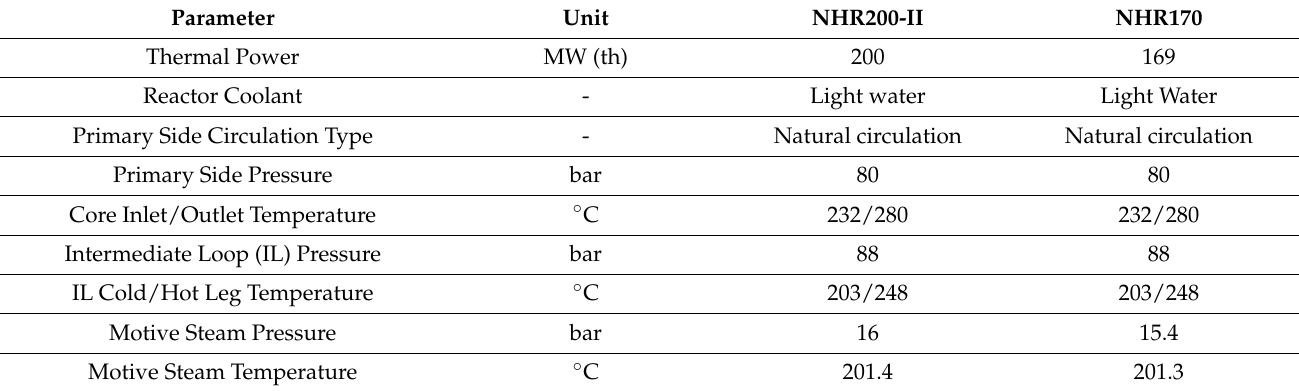
Figure 4. Structure and cross section of the NHR200-II. Table 7. Main Operating Parameters for NHR200-II and NHR170.